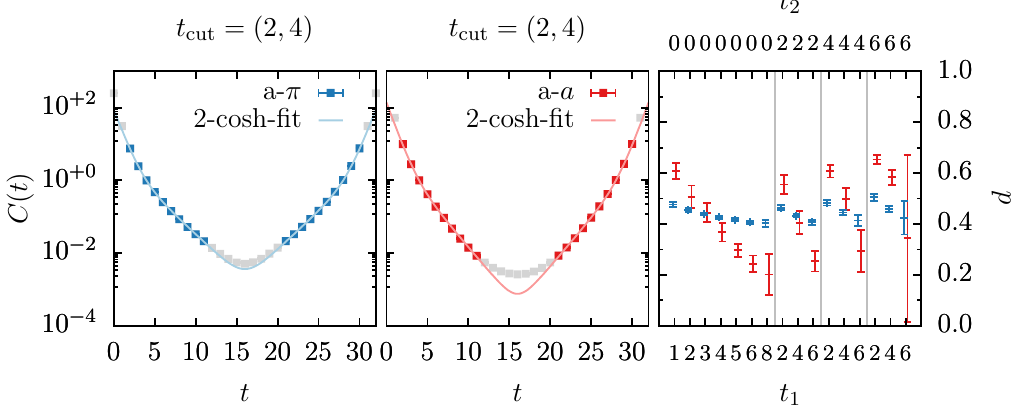
Figure 3 . Left/Center: a- π resp. a- a correlator at β = 5 . 4 and ( m, m 5 ) = ( -0.8950 , 0.0 ) with 2- cosh-fits. The gray data points are excluded from the fit to reduce contributions from higher states and to stabilize the fit. Error bars are smaller than the symbol size. Right: the dominant mass contribution d from fits with different cuts t cut = ( t 1 , t 2 ) . The gray vertical lines separate regions with different values of t 2